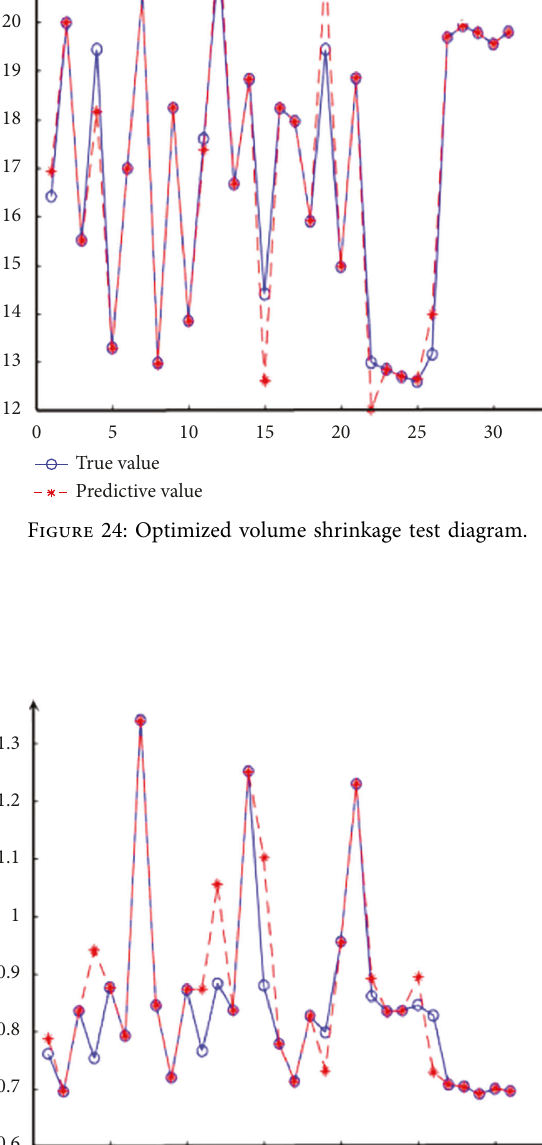
Table 17: Comparison table of neural network models before and after